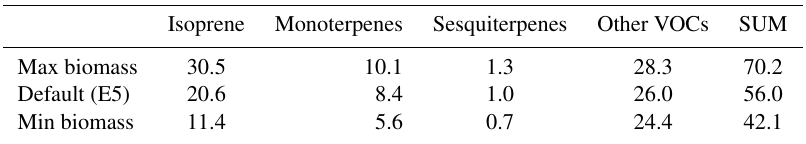
Table 7. The estimations of BVOC emissions (Gg) by adopting CCI LC with maximum biomass, minimum biomass and default cross- walking tables.